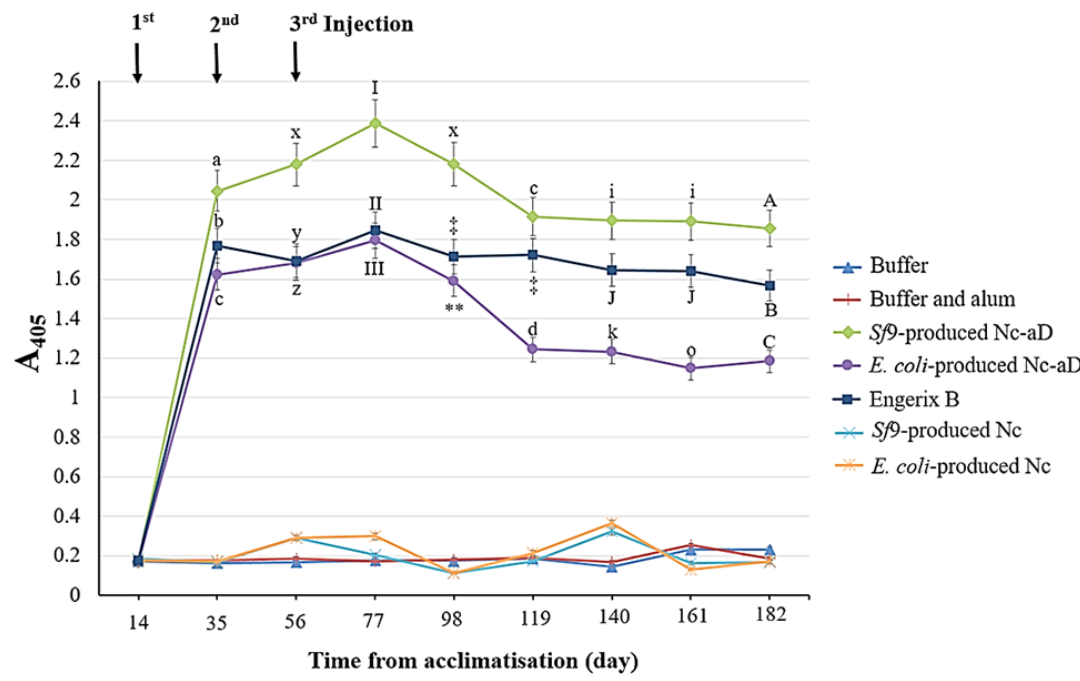
Figure 3. Immunogenicity of the Sf 9-produced Nc-aD VLPs in BALB/c mice. ELISA was performed to determine the immunogenicity of the Sf 9-produced Nc-aD VLPs and the control groups. The ELISA plate was coated with a synthetic aD peptide, and reacted with serum samples from the immunised mice. Mice were acclimatised from day 0 to 14 and immunised with the primary injection on day 14. The first and second booster doses were administered on days 35 and 56, respectively. The letters (a, b, c, d, A, B, C, i, J, k, o, x, y, z) and symbols (I, II, III, ‡, ** ) represent the statistical significance of the measurements at each time point. Measurements marked by different letters/symbols are significantly different ( p < 0.001), and those marked by the same letters/symbols are not significantly different. The error bars indicate the standard deviation (SD) of triplicate